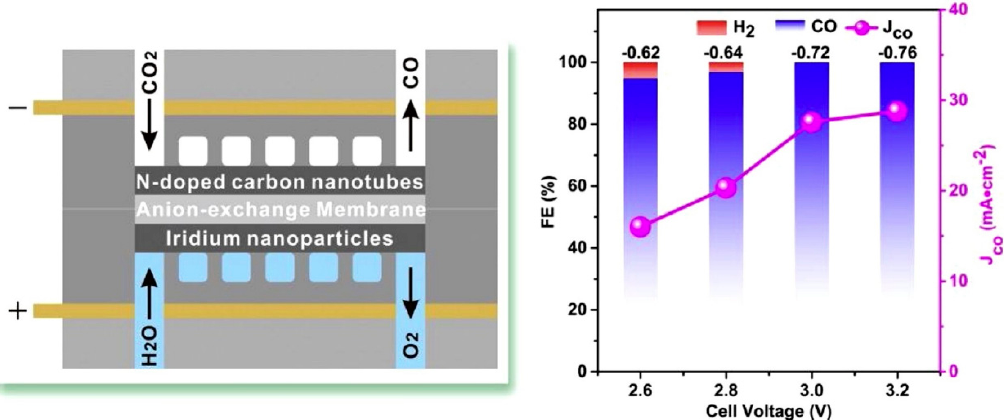
Figure 8. Gas − phase electrolysis in a flow cell and gas-phase CO 2 electrolysis. FE of CO (blue) and H 2 (red) vs. cell voltage (left axis) and partial current density of CO vs. cell voltage (right axis), values above the column are cathode potentials vs. normal hydrogen electrode (NHE) (Reprinted with permission from Ref. [121]. Copyright 2019 Elsevier).